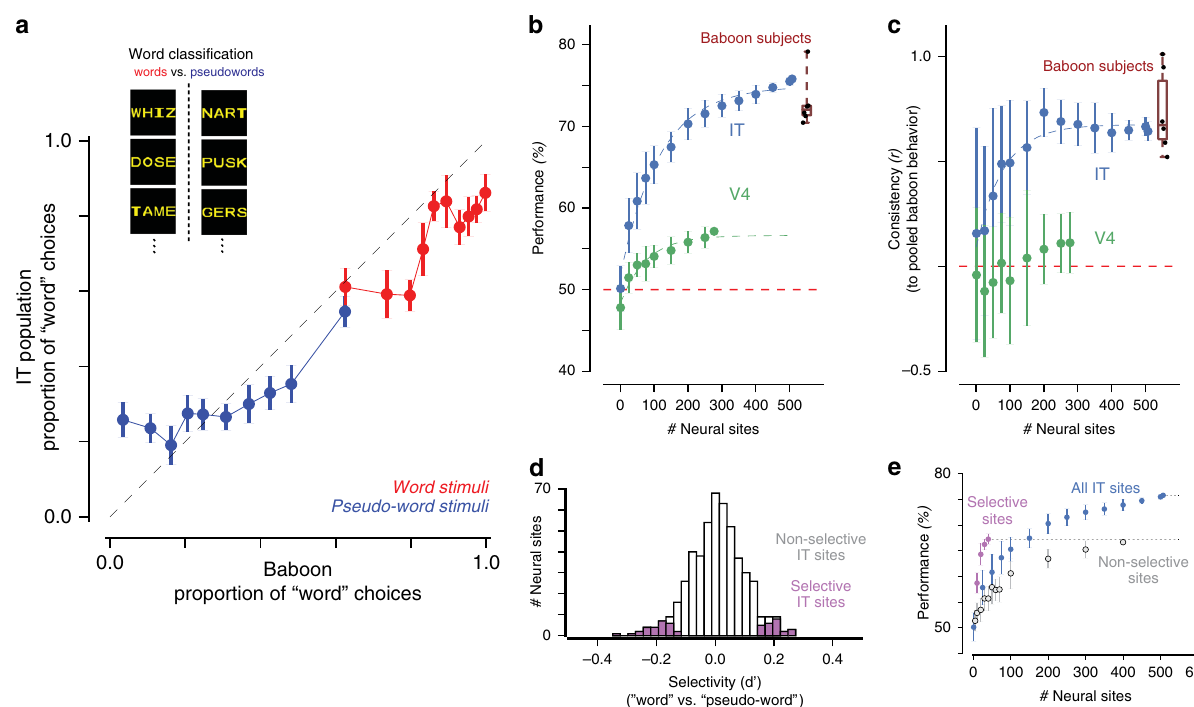
Fig. 2 Suf fi ciency of IT population for word classi fi cation. a Comparison of baboon behavior and a linear readout of IT neurons, plotted as the proportion of stimuli categorized as “ words. ” The 616 individual stimuli were grouped into equally sized bins based on the baboon performance, separately for words (red) and pseudowords (blue). Error bars correspond to SEM, obtained via bootstrap resampling over stimuli ( n = 100 bootstrap samples); dashed line corresponds to unity line, demarking a perfect match between baboon behavior and IT-based decoder outputs. b Performance of decoders trained on IT and V4 representations on word classi fi cation, for varying number of neural sites. Distribution of individual baboon performance is shown on the right (median 72%, interquartile range = 1%, data range = 8.7%, n = 6 baboon subjects). c Consistency with baboon behavioral patterns of decoders trained on IT and V4 representations, for varying number of neural sites. Distribution of individual baboon consistency is shown on the right (median ~ ρ ¼ 0 : 67, interquartile range = 0.27, data range = 0.49, n = 6 baboon subjects). d Distribution of selectivity of word classi fi cation for individual IT sites, highlighting the subpopulation of sites with selectivity signi fi cantly different from zero. e Performance of decoders trained on subpopulation of selective sites from d compared to remaining IT sites and all IT sites. Error bars in b , c , and e correspond to SD across samples of neural sites ( n = 100 feature